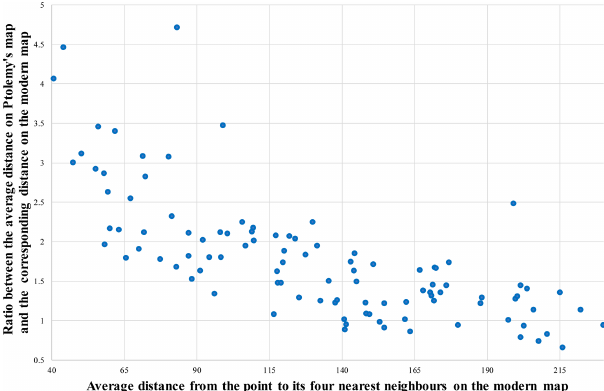
Figure 6. Deviation of the sum of the coastal segments in Ptolemy from the sum of the corresponding segments in Pseudo-Arrian’s Periplous ( y axis) as a function of Pseudo-Arrian’s values for the length of individual segments ( x axis).